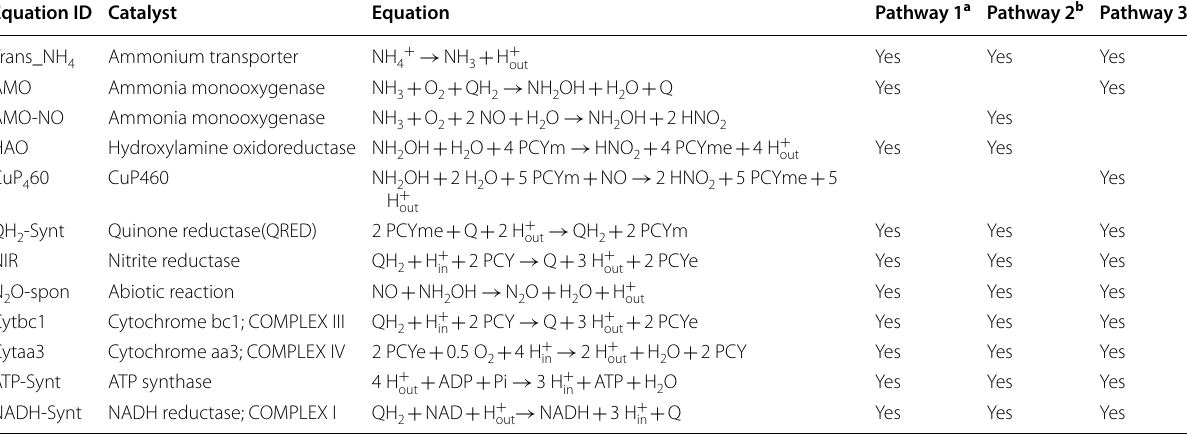
a Walker et al. (2010), b Schleper and Nicol (2010), c (Kozlowski et al. 2016)